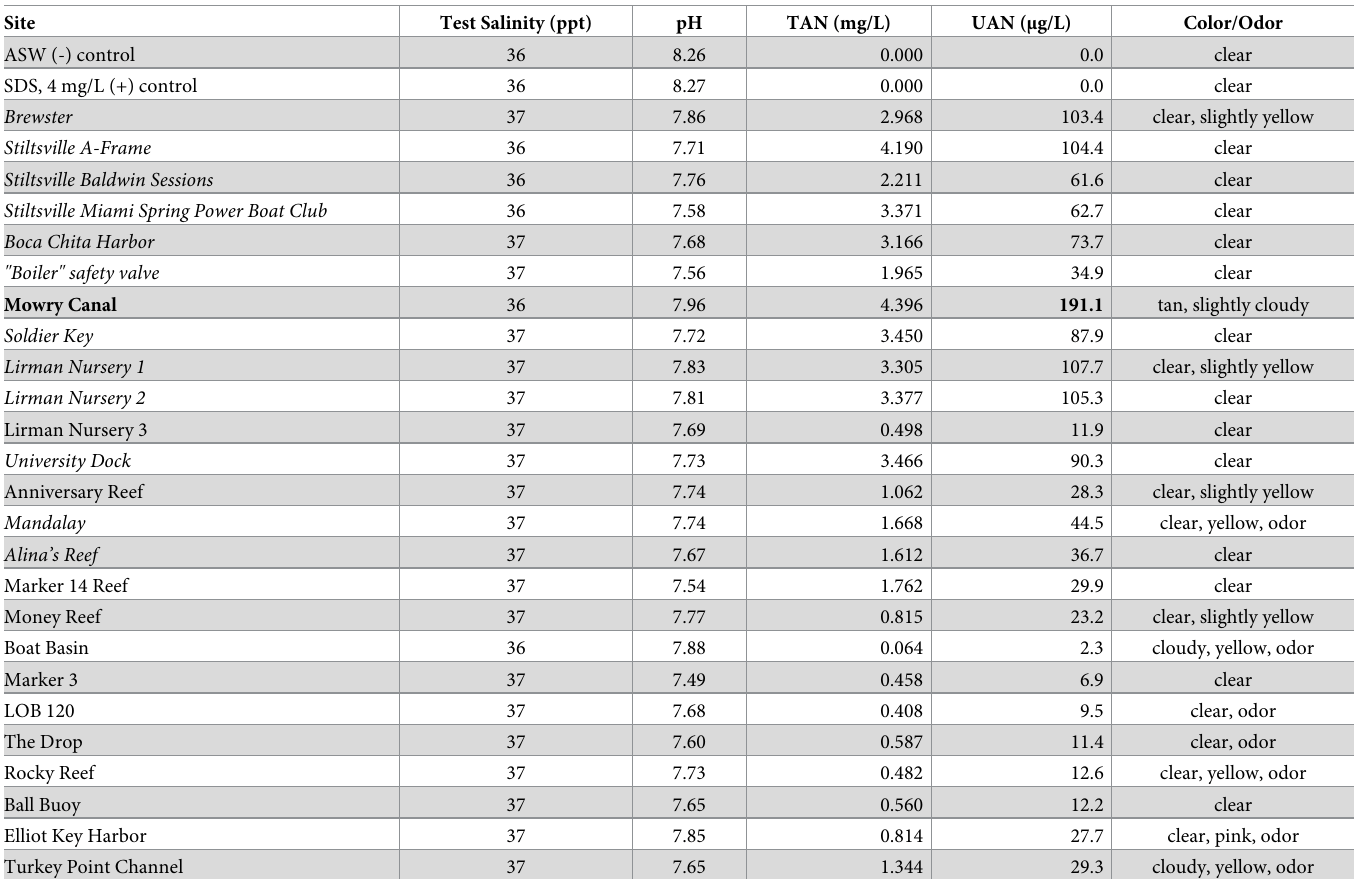
Table 2. Water quality results for control and Biscayne National Park sediment porewater samples.